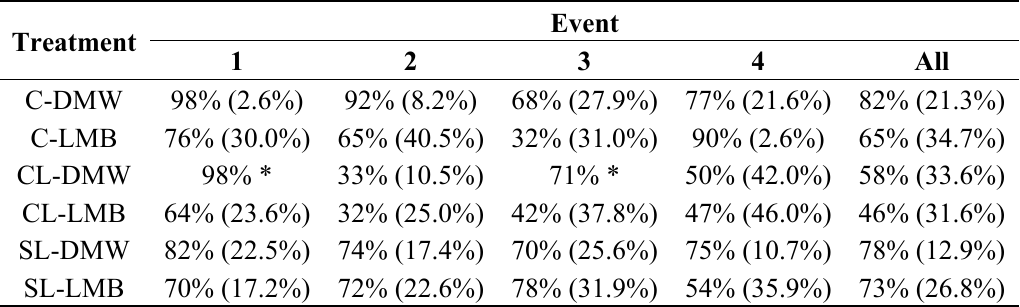
Table 4. The risk to reject the hypothesis that the distribution of tracer concentration across collectors follows a lognormal PDF while it is true. All tracers are summarized for each event of each treatment (mean and standard